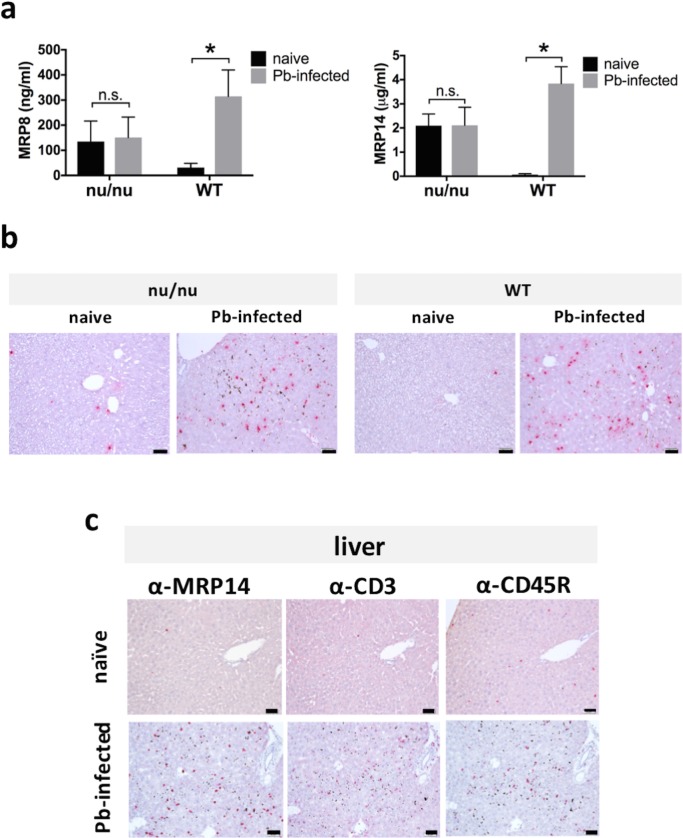
Increase of extracellular MRP14 depend on T cells during rodent malaria.(a) Serum concentration of MRP8 (left) and MRP14 (right) of nu/nu mice and WT mice after Pb-infection (n = 5). (b) The accumulation of MRP14+ cells in the liver of nu/nu mice and WT mice after Pb-infection. RP, red pulp; WP, white pulp. Bars; 50 µm. (c) The accumulation of MRP14+ cells, CD3+ cells and CD45+ cells in the liver of Pb-infected mice. RP, red pulp; WP, white pulp. Bars; 50 µm. Graphs show mean and SD of each group. Data are representative of two independent experiments. *P < 0.05; n.s., not significant.